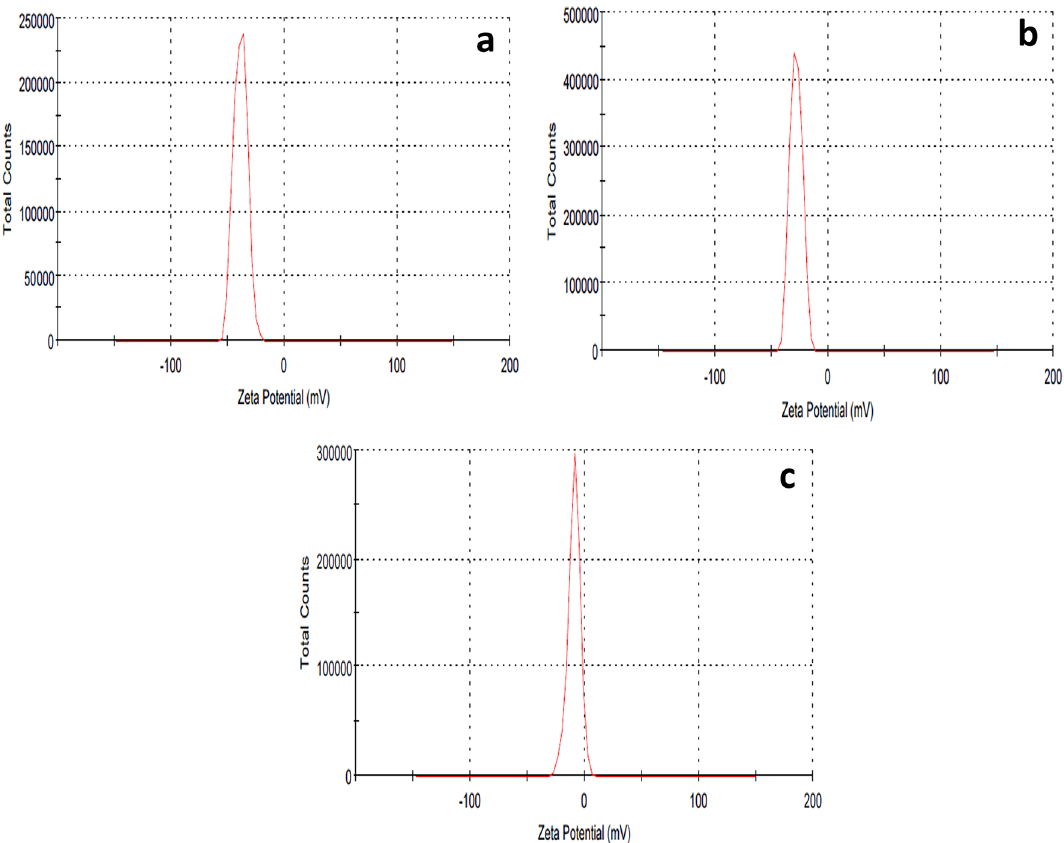
Figure 3. Zeta potential of ( a ) cinnamon AgNPs, ( b ) ginger AgNPs and ( c ) chemical